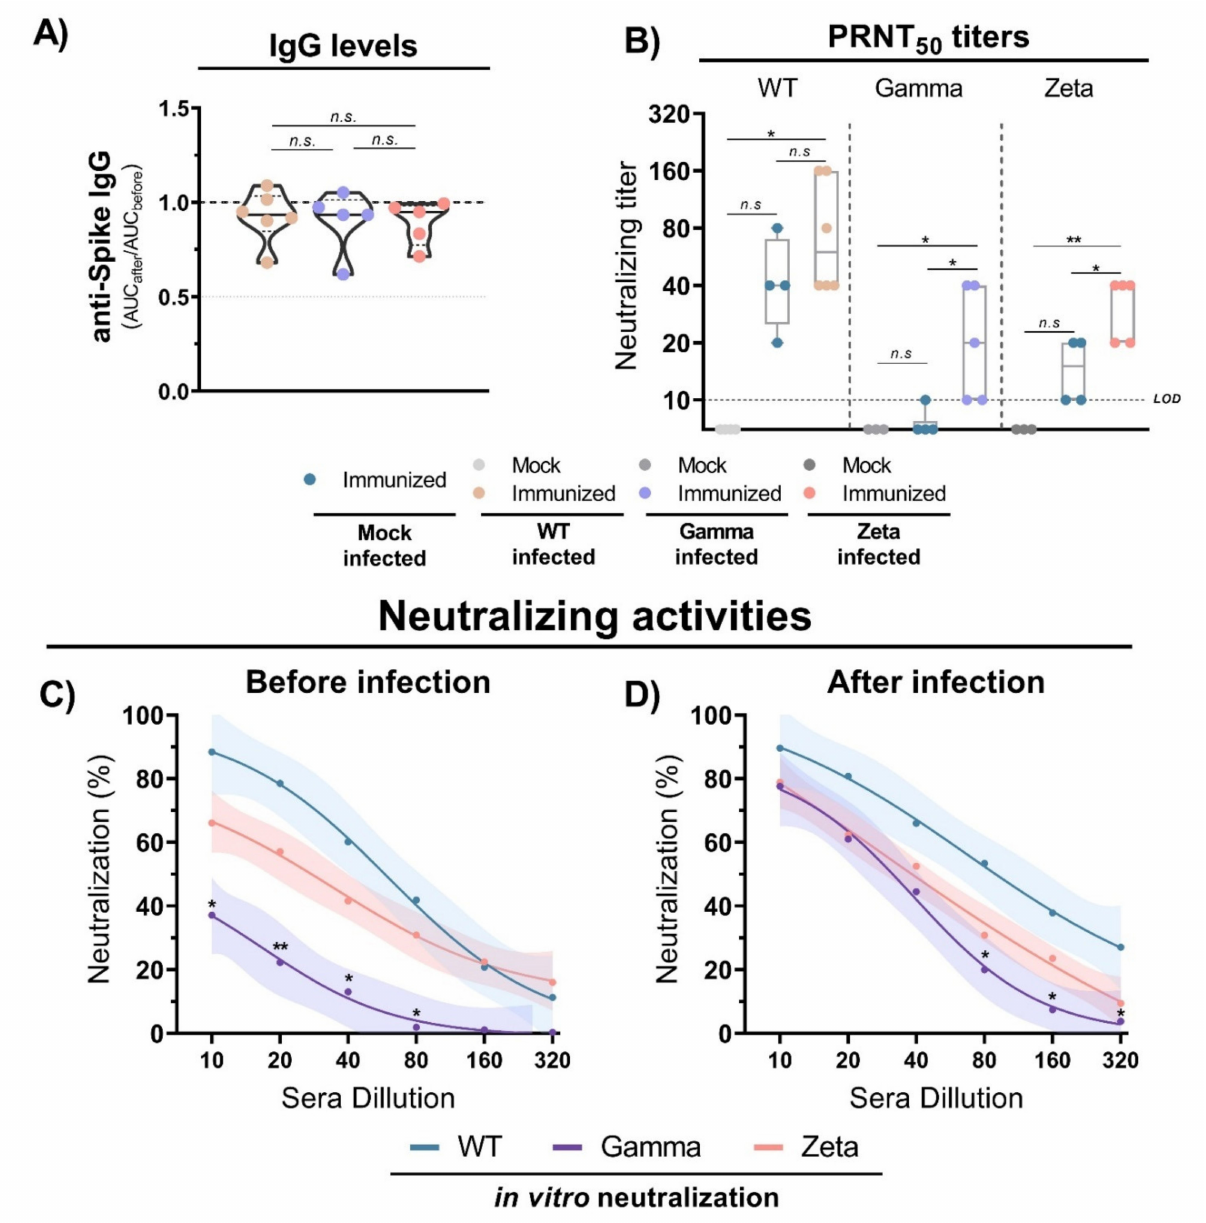
Figure 6. Antibody titers and neutralization activity in mice immunized with WT SARS-CoV-2 and infection with different viral lineages. ( A ) Anti-S IgG level ratio from immunized mice sera before and after viral infection with WT SARS-CoV-2, Gamma or Zeta lineages, normalized. N= 5–6 animals/group (indicated on figure). Multiple comparisons performed by ordinary one-way ANOVA followed by Tukey’s post hoc test. ( B ) Neutralizing titers in PRNT50 of immunized (n = 4) and nonimmunized (n = 3) mouse sera before and after viral infection with WT SARS-CoV-2 (n = 6), Gamma (n = 5), or Zeta (n = 5) lineages. ( C , D ) Neutralizing profile against WT SARS-CoV-2, Gamma, or Zeta lineages from immunized mouse sera before (n = 4) and 3 days after (n = 6, for each group) viral infection. Nonlinear regression curves generated with a maximum of 1000 interactions and 95% confidence interval. Error bars delimited by colors. Multiple comparisons performed by two-way ANOVA followed by Tukey’s post hoc test. * p < 0.05; ** p < 0.001. AUC = area under curve; PRNT50 = 50% plaque reduction neutralization test; LOD = limit of detection; n.s. = not statistically